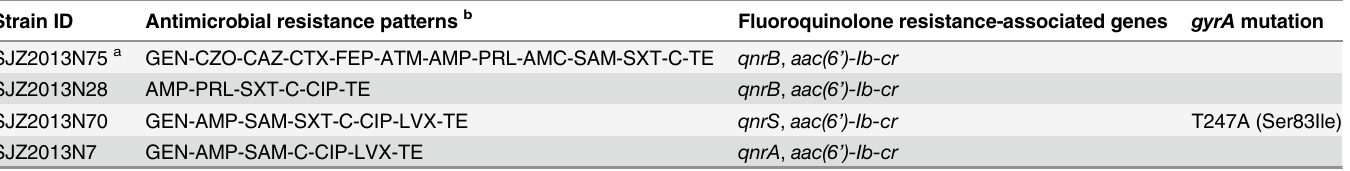
Table 4. Characteristics of the Fluoroquinolone Resistance-Associated Genes in 4 Fluoroquinolone-Resistant or Intermediately Fluoroquinolone- Resistant K . pneumoniae Isolates Detected in this Study. Strain ID Antimicrobial resistance patterns